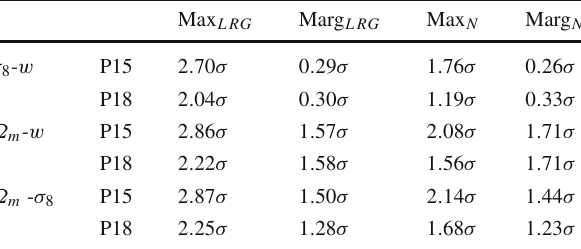
Table 4 Tension levels for the Planck 2015 and Planck 2018 Λ CDM cosmologiesinthedifferenttwo-dimensionalmaximizedandmarginal- ized regions for the datasets in Table 2 ( N ) and in [12]